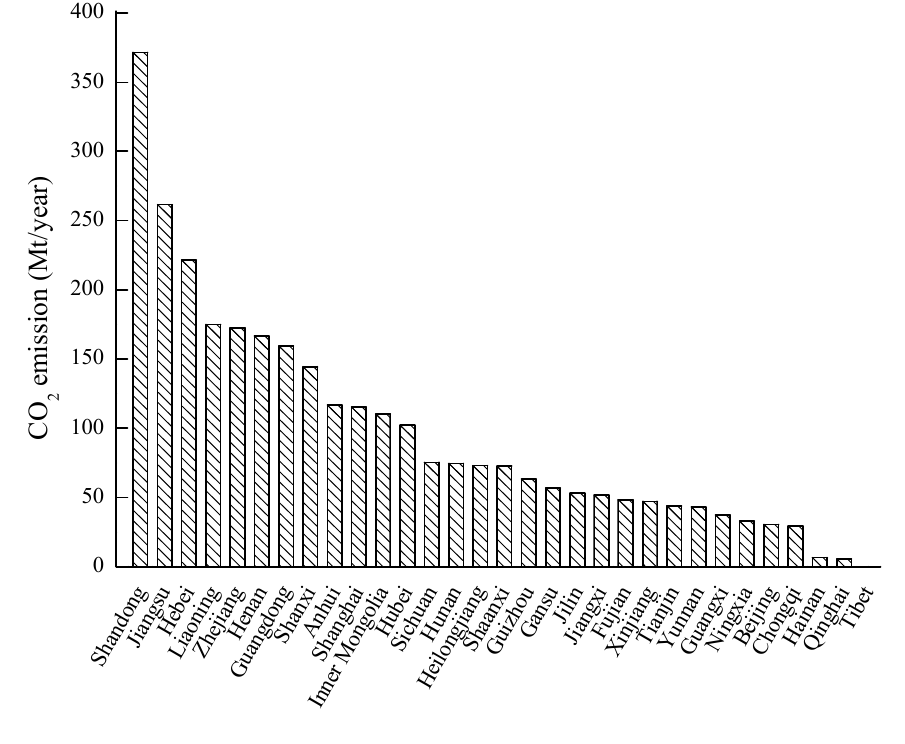
Table 4. Biomass productivity, CO